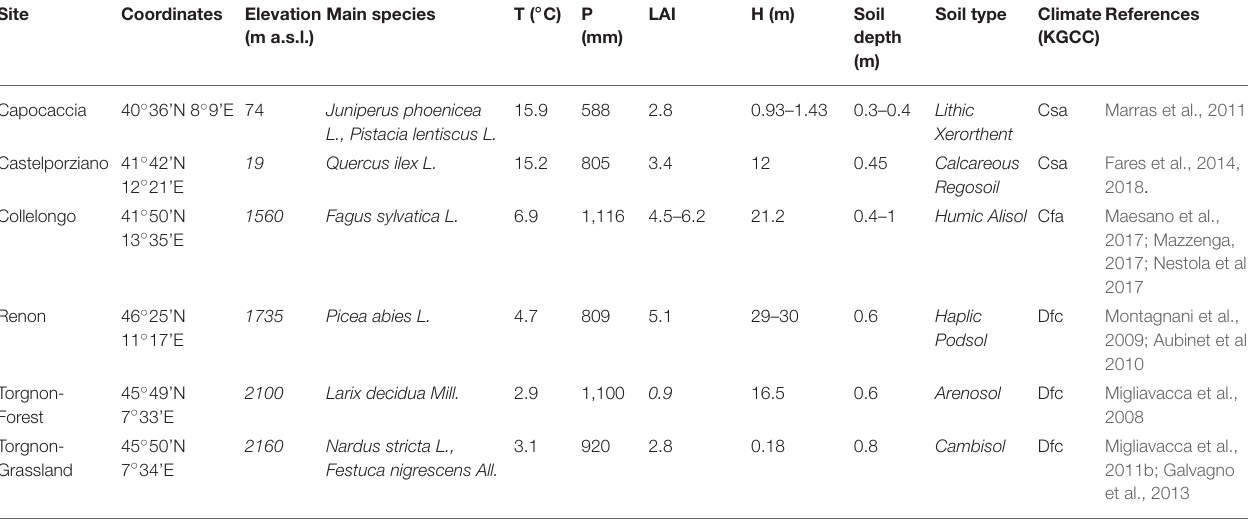
TABLE 1 | Main characteristics of the experimental sites.